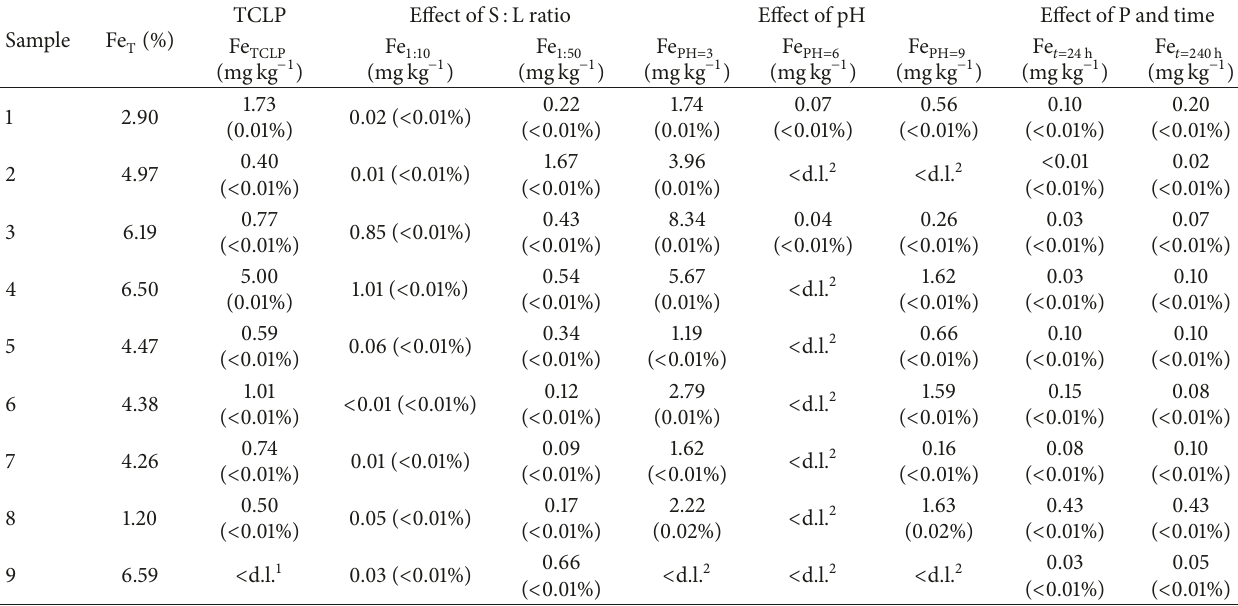
Table 3: Fe leachability in TCLP and the effect of pH, solid:liquid ratio, phosphorous, and time on Fe